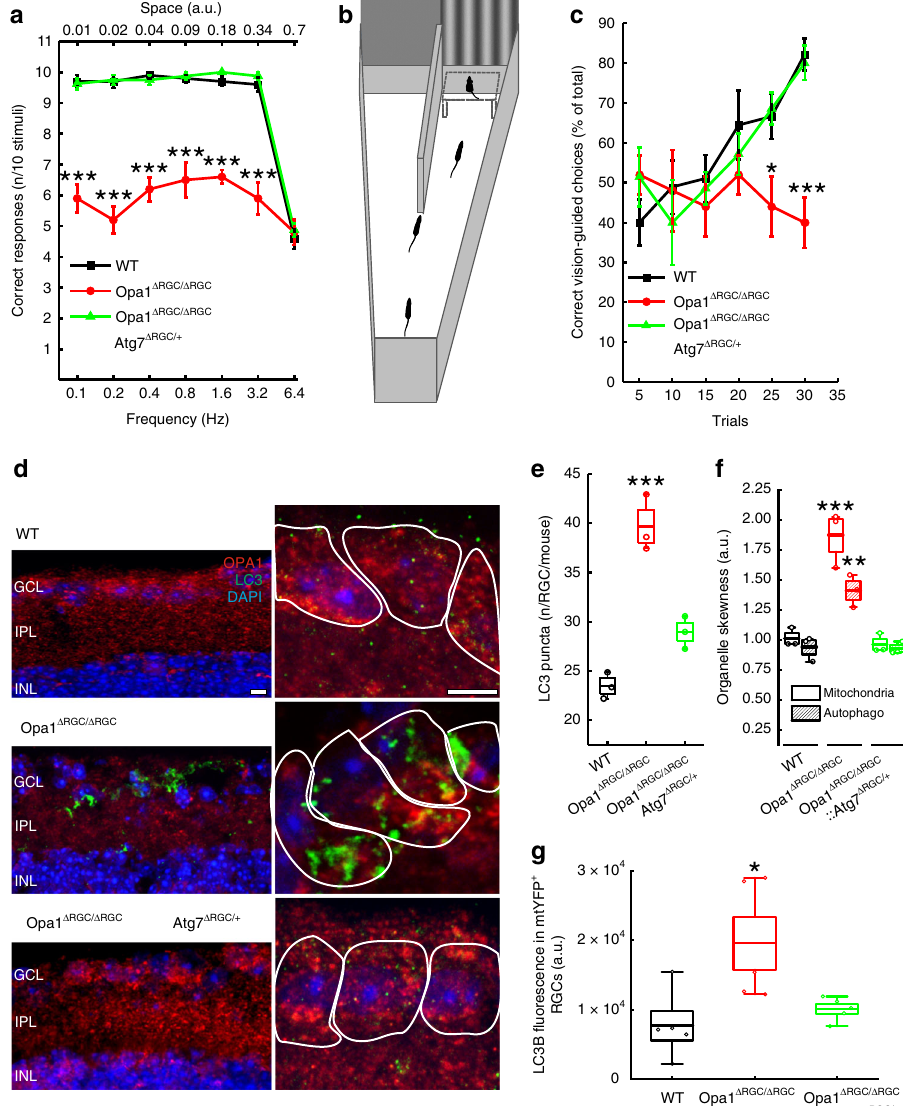
Fig. 5 Genetic autophagy inhibition curtails the visual defect of an ADOA mouse model. a Average±SEM visual acuity of 4-month-old mice of the indicated genotype in the optokinetic test. Mice were subjected to visual stimuli at the indicated temporal and spatial frequencies. Visual acuity is proportional to the percentage of correct answers to the stimulus. WT, n = 10; Opa1 Δ RGC/ Δ RGC , n = 10; Opa1 Δ RGC/ Δ RGC Atg7 Δ RGC/ + , n = 8 mice. **** p <0.0001 vs. WT in two-way ANOVA/Tukey ’ s test. b A schematic of the Y-shaped pool used for the vision guided forced-swimming test. The two screens (gray and vertically striped) used as visual cues and the submerged platform are shown. c Average±SEM visual acuity of 4-month-old mice of the indicated genotype in the vision guided forced-swimming test. WT, n = 9; Opa1 Δ RGC/ Δ RGC , n = 5; Opa1 Δ RGC/ Δ RGC Atg7 Δ RGC/ + , n = 7 mice. * p = 0.05, *** p = 0.0001 vs. WT in two-way ANOVA/Tukey test. d Representative z-projections of stacks of confocal images of the fl uorescence of OPA1 (red), LC3B (green), and DAPI (blue) of retinal slices of 4-month-old mice of the indicated genotype. The soma of RGCs are circled with white lines in right panels. Bars, 20 μ m. GCL ganglion cell layer, IPL inner plexiform layer, INL inner nuclear layer. e Quanti fi cation of RGCs autophagosomes number in three independent experiments as in ( d ). WT, n = 163; Opa1 Δ RGC/ Δ RGC , n = 155; Opa1 Δ RGC/ Δ RGC Atg7 Δ RGC/ + , n = 156 cells. *** p = 0.0002 vs. WT in one-way ANOVA/Bonferroni ’ s test. f Quanti fi cation of mitochondria and autophagosomes accumulation in axonal hillocks of RGCs in three independent experiments as in ( d ). For mitochondria, WT, n = 165; Opa1 Δ RGC/ Δ RGC , n = 155; Opa1 Δ RGC/ Δ RGC Atg7 Δ RGC/ + , n = 156; for autophagosomes, WT, n = 164; Opa1 Δ RGC/ Δ RGC , n = 155; Opa1 Δ RGC/ Δ RGC Atg7 Δ RGC/ + , n = 155 cells. ** p = 0.003 *** p = 0.001 vs. WT in one-way ANOVA/Tukey ’ s test. g Quanti fi cation of anti-LC3B antibody signal in sorted mtYFP + RGCs from fi ve animals of each indicated genotype. * p = 0.012 vs. WT in one-way ANOVA/Kruskal – Walli ’ s test. In box plots, centre line represents mean, bounds of boxes SEM, whiskers the 10 th – 90 th percentiles; each dot represents an individual nematode form the indicated N of independent experiments. Source data are provided as a Source Data fi